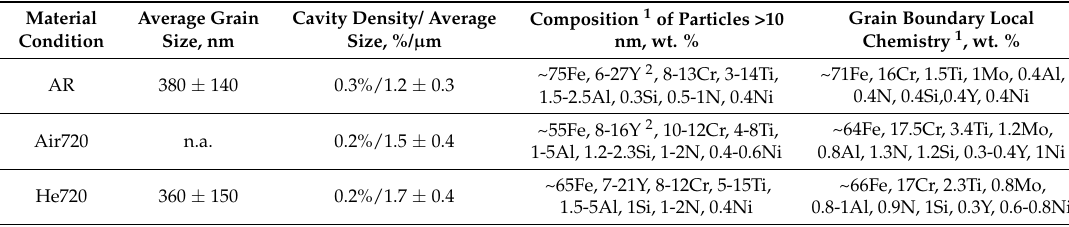
Table 2. Characteristics of the 14Cr ODS steel